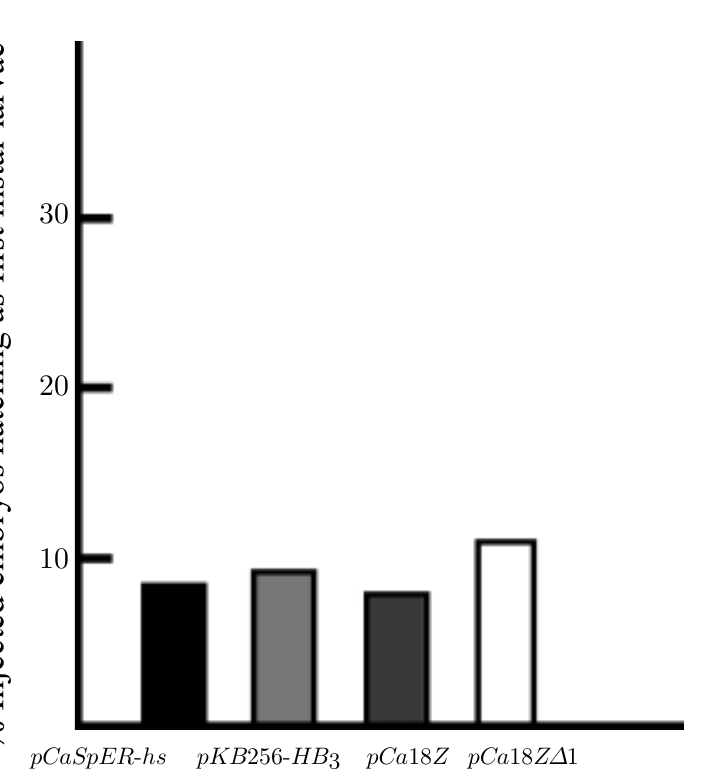
Fig. 3 – Percentage of larvae hatching from embryos injected before cellularization with plasmids carrying the same rst-irreC constructs and control as in figure 2. No obvious survival differences could be detected between the injected